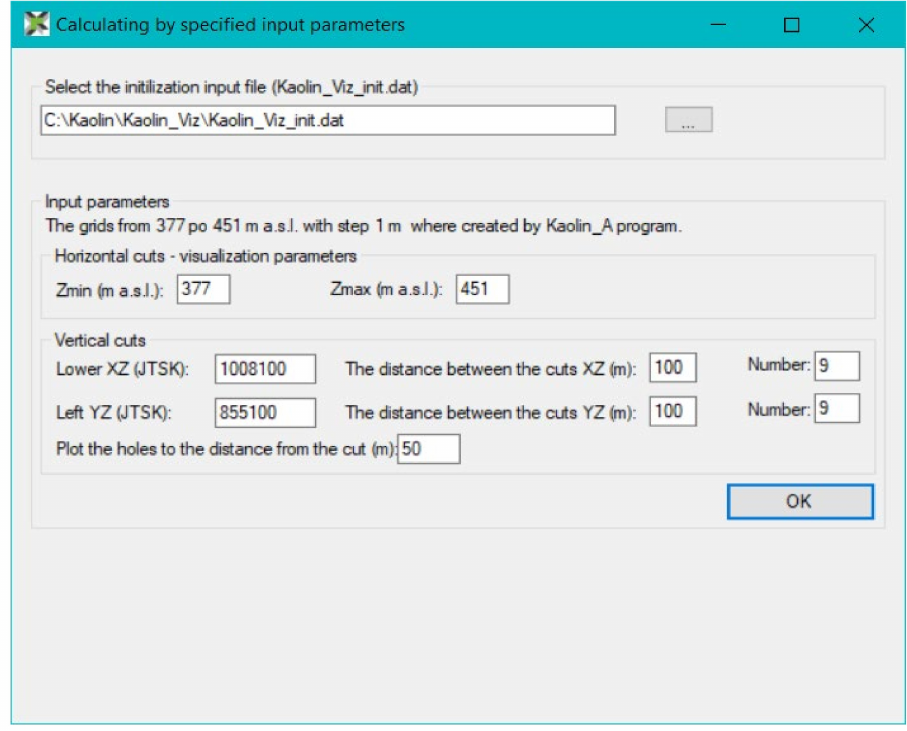
Figure 16. Window of program Kaolin_Viz for setting the calculate parameters. The program Kaolin_Viz contains four modules. The buttons for starting the indi- vidual program modules (Figure 17) are displayed after entering the input parameters (Figure 16) and pressing the “OK” button.